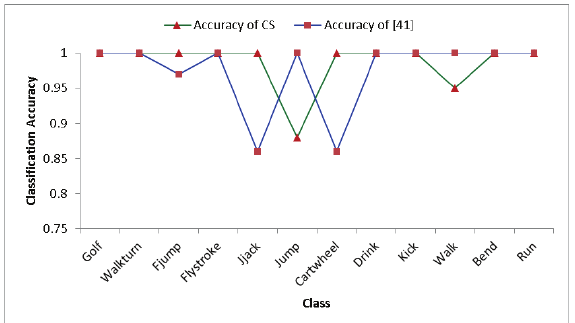
Fig. 4. Comparison of the classification accuracy of the discovered contrast sets with the classification accuracy of the method proposed by Junejo and Al Aghbari. 41